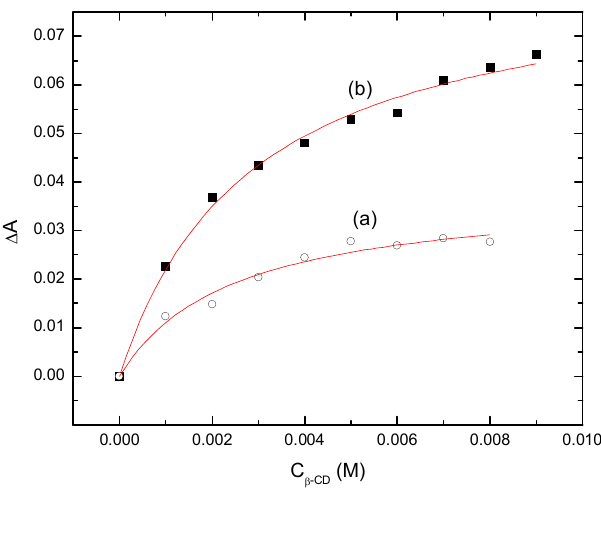
Figure 4. UV-Vis titration isotherms for  -CD and guest molecules at pH 9.0 and 295 K; ( a ) 2,4-D where  = 290 nm; and ( b ) 2,4-DCP where  max represent the nonlinear least squares fit, according to a 1:1 equilibrium host-guest binding model